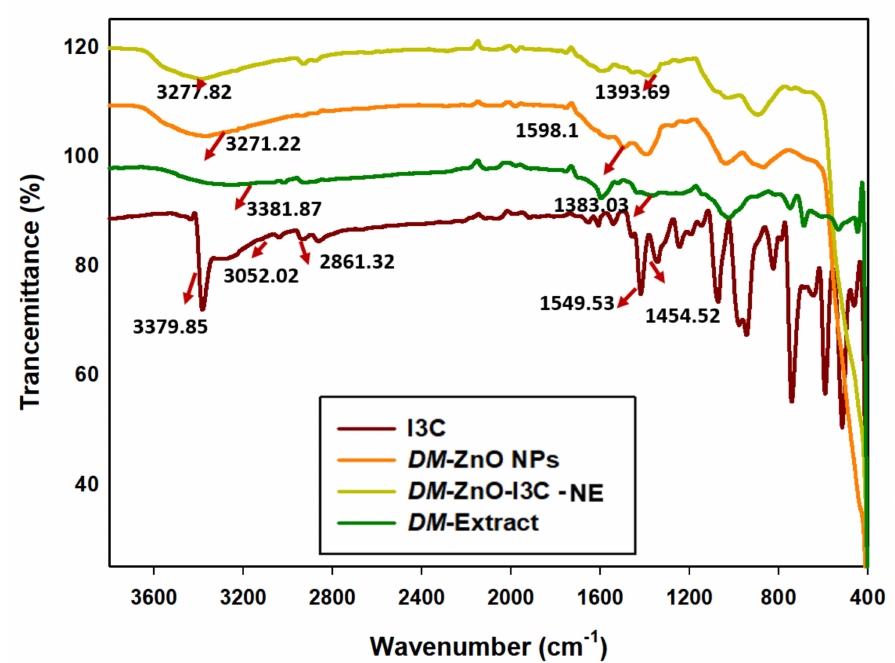
Figure 3. Fourier transforms infrared analysis (FTIR) for I3C standard (Red), DM -ZnO NPs (orange) DM -ZnO-I3C-NE (yellow) and DM extract